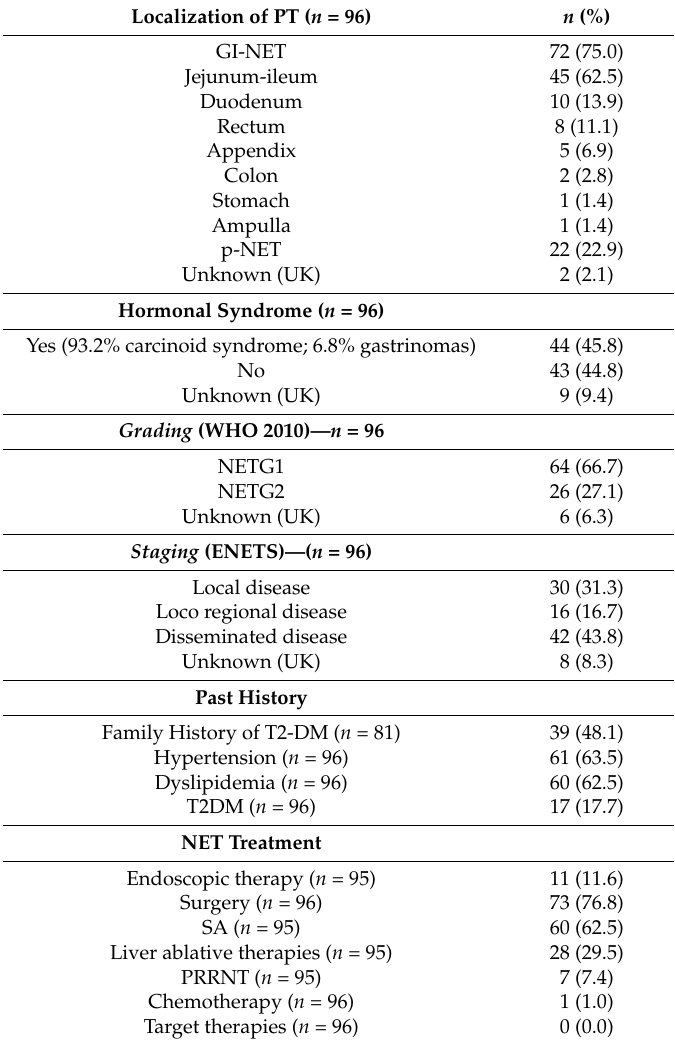
Table 3. WD GEP-NETs patient